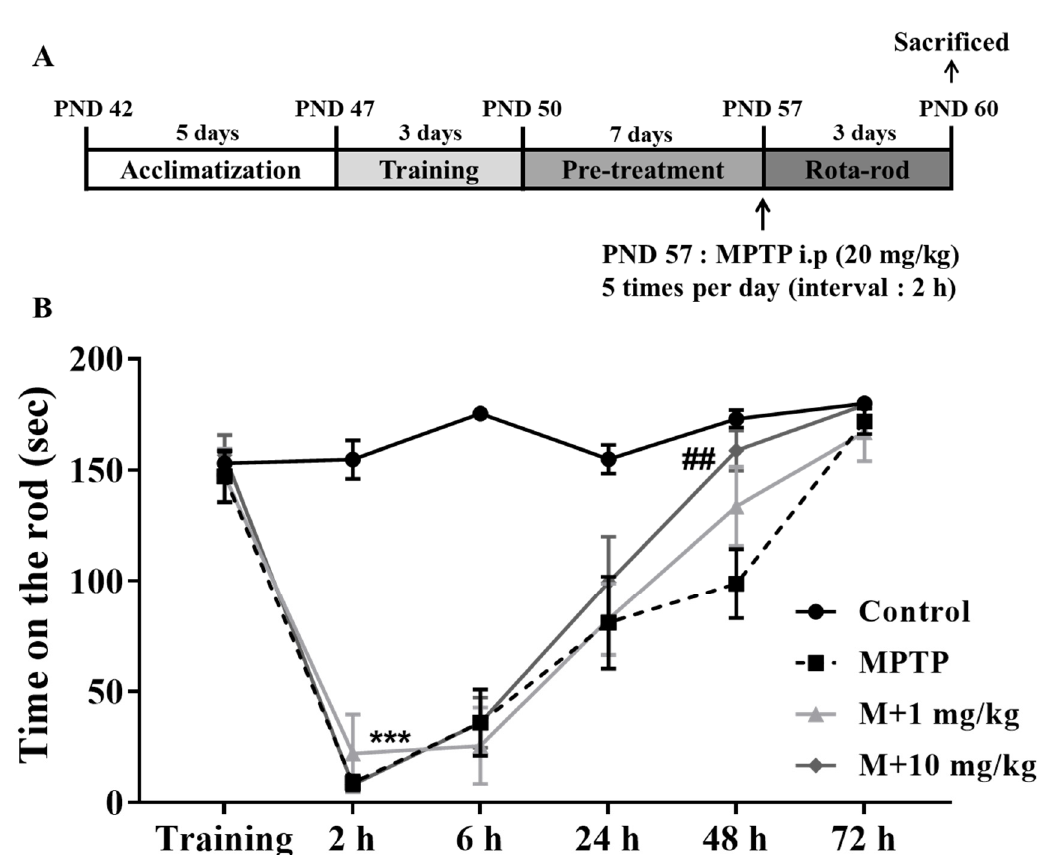
Figure 4. MHY2699 improved MPTP-induced motor deficits in a mouse model of PD. ( A ) In vivo experiment design. ( B ) The Rota-rod test was performed to evaluate motor function. The mice were pretrained for three days to remain on the rod at 15 to 30 rpm. The tests were performed at 2, 6, 24, 48 h, and 72 h after the last MPTP injection at a rod speed of 30 rpm. The values are reported as the means ± SEs ( n = 10–11 mice/group). *** p < 0.001 versus treatment naïve controls and ## p < 0.01 versus the MPTP treated group (the analysis was performed using ANOVA with Tukey’s multiple compari- sons).